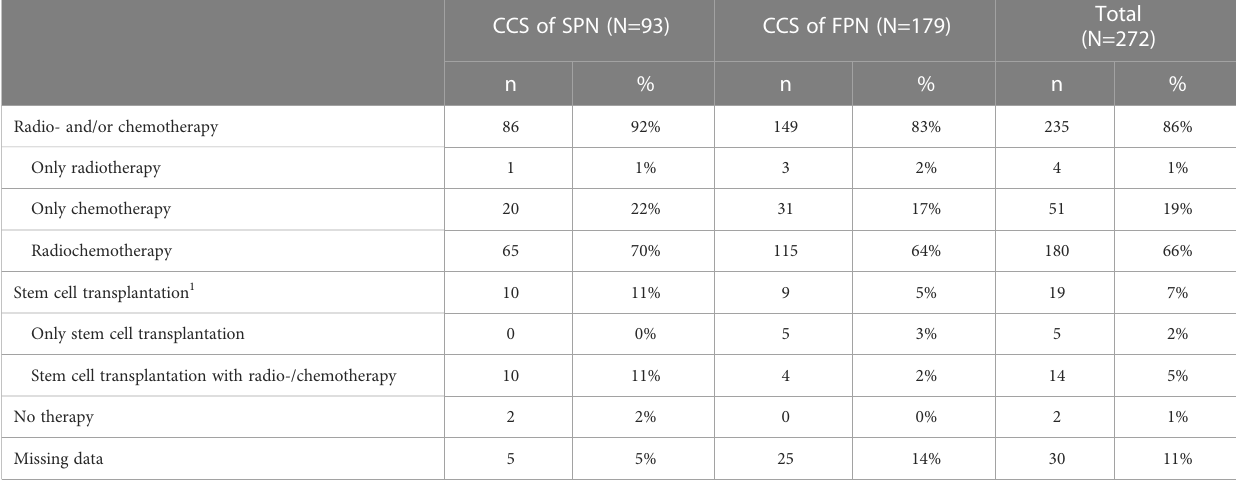
TABLE 2 Available therapy information from medical records of KiKme study participants.